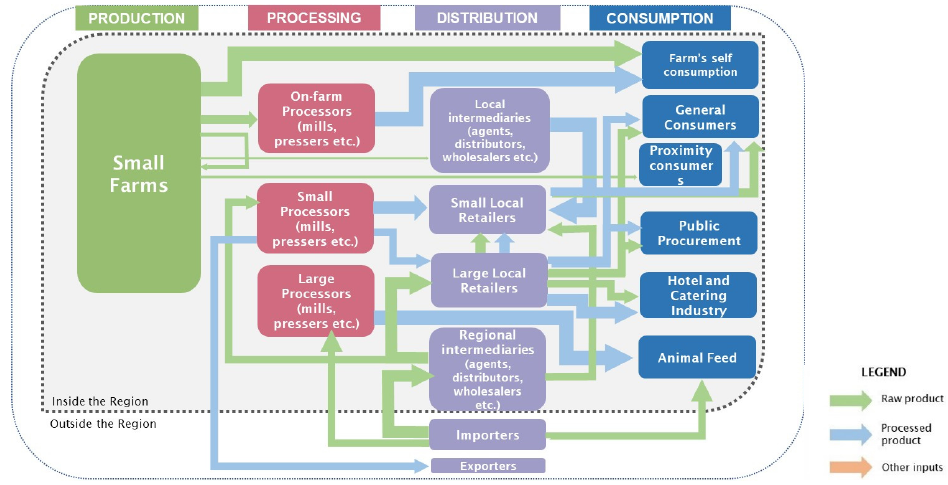
Figure 5. Regional food system for maize.